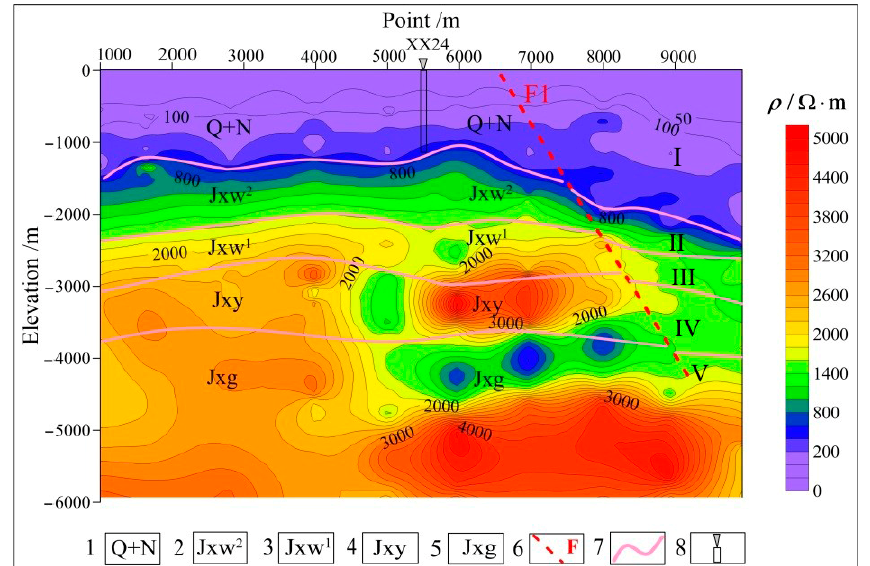
Figure 3. Integrated MT interpretation of the section of survey line L1. 1, Quaternary ‒ Neogene; 2, upper component of the Jixianian Wumishan formation; 3, lower component of the Jixianian Wumishan formation; 4, Jixianian Yangzhuang formation; 5, Jixianian Gaoyuzhuang formation; 6, inferred fault; 7, stratigraphic boundary; 8, borehole.